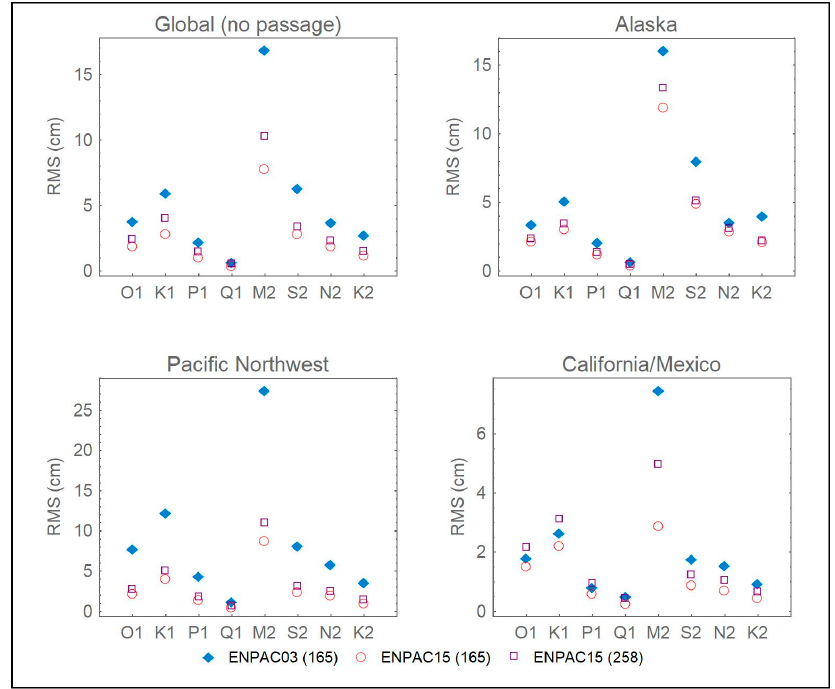
Figure 9. Mean root mean square errors (cm) in harmonic constituents for the ENPAC03 and ENPAC15 ADCIRC tidal databases for each region of the ENPAC model domain (note that the scale is not the same for each region).